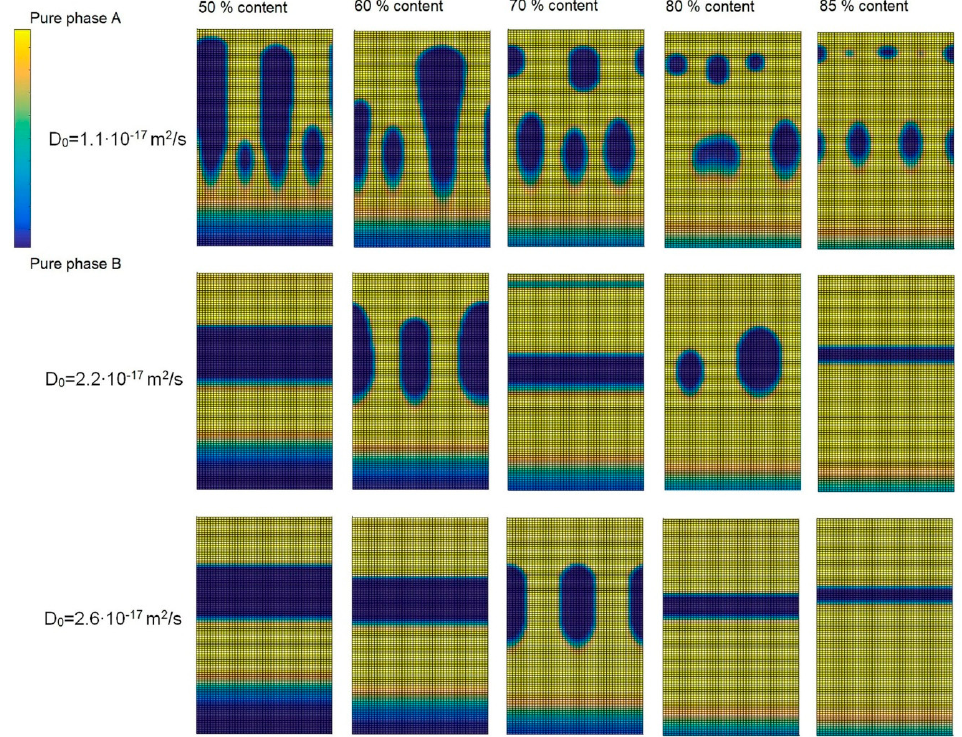
Figure 1. The calculated cross-sectional views of binary thin films at different diffusion coefficients and binary film compositions.